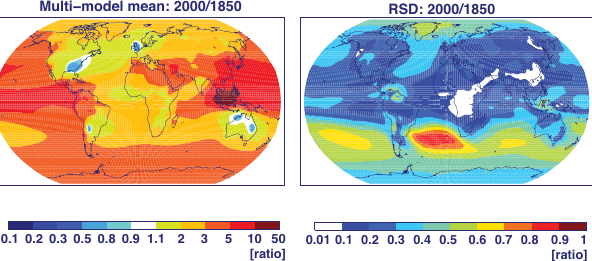
Multi−model mean: 2000/1850 RSD: 2000/1850